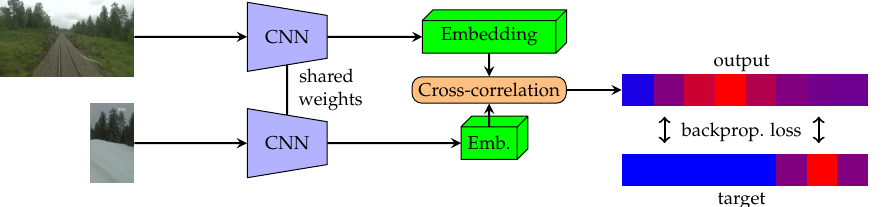
Figure 1. Diagram depicting the scheme of the training pipeline for the Siamese network models presented in the paper. Training is done over pairs of image and a cutout of another image of the same scene at a different time. The network itself then consists of the backbone with shared weights and a final cross-correlation layer which gives the final output.